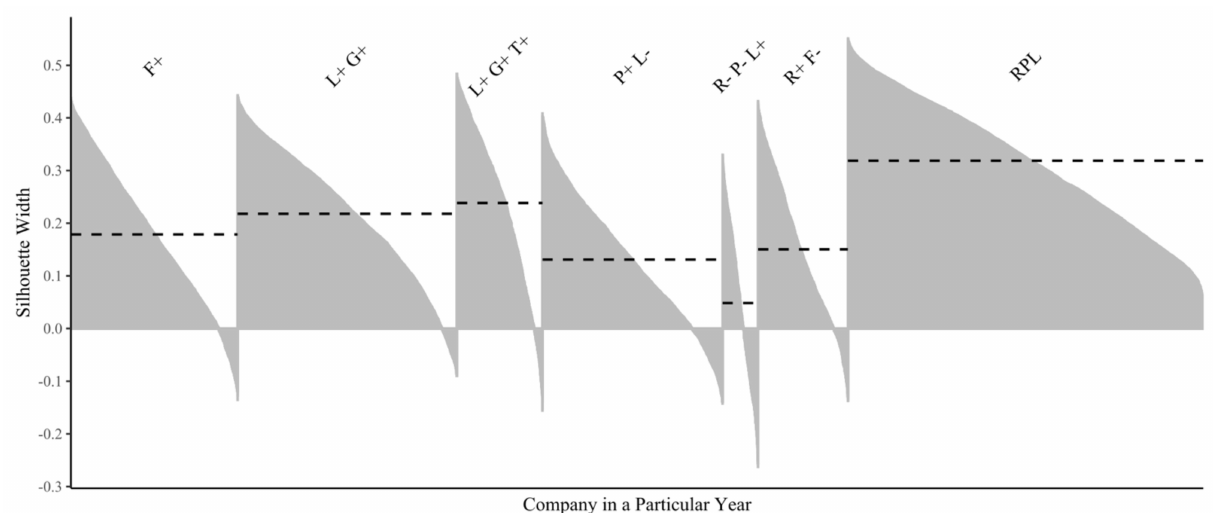
Figure 8. Silhouette metric values for all companies by cluster (the dotted line shows the mean silhouette value for each cluster).